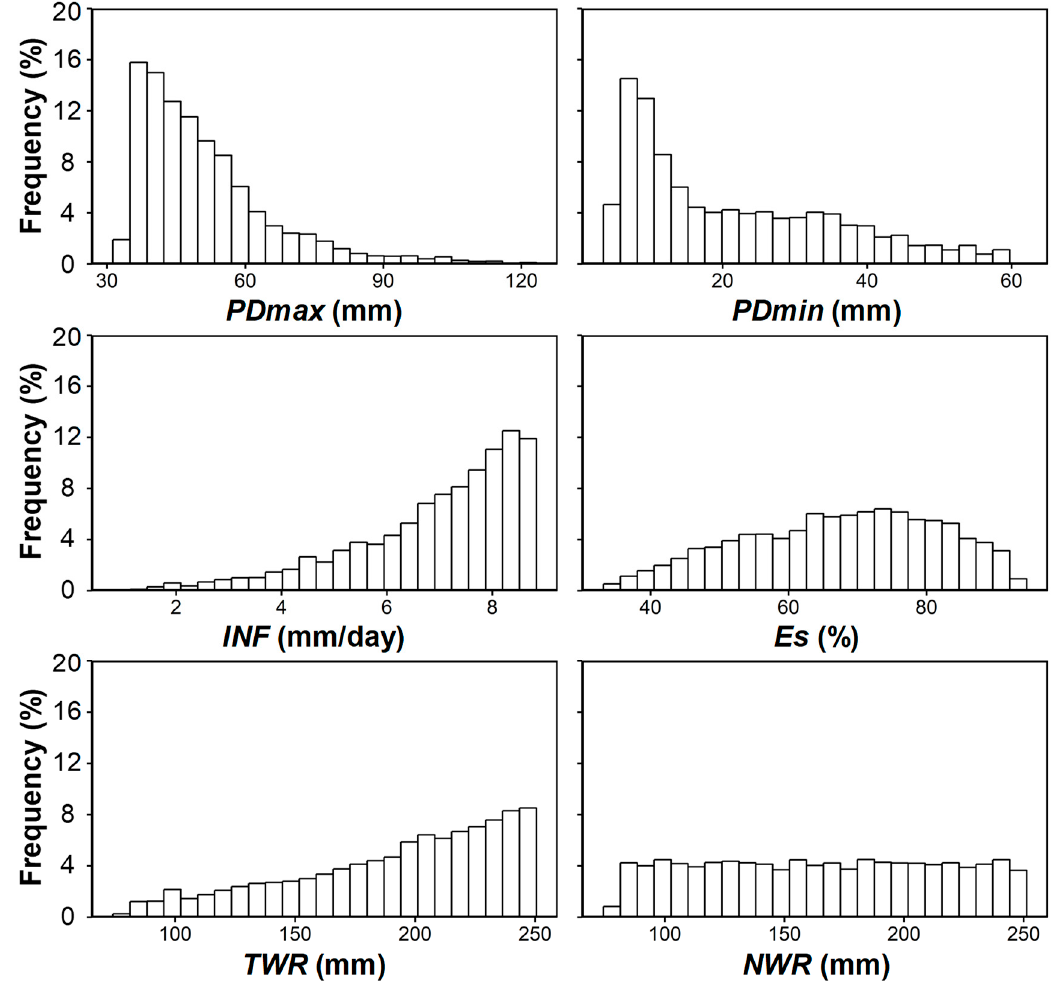
Figure 3. Frequency histograms of behavioral parameters.